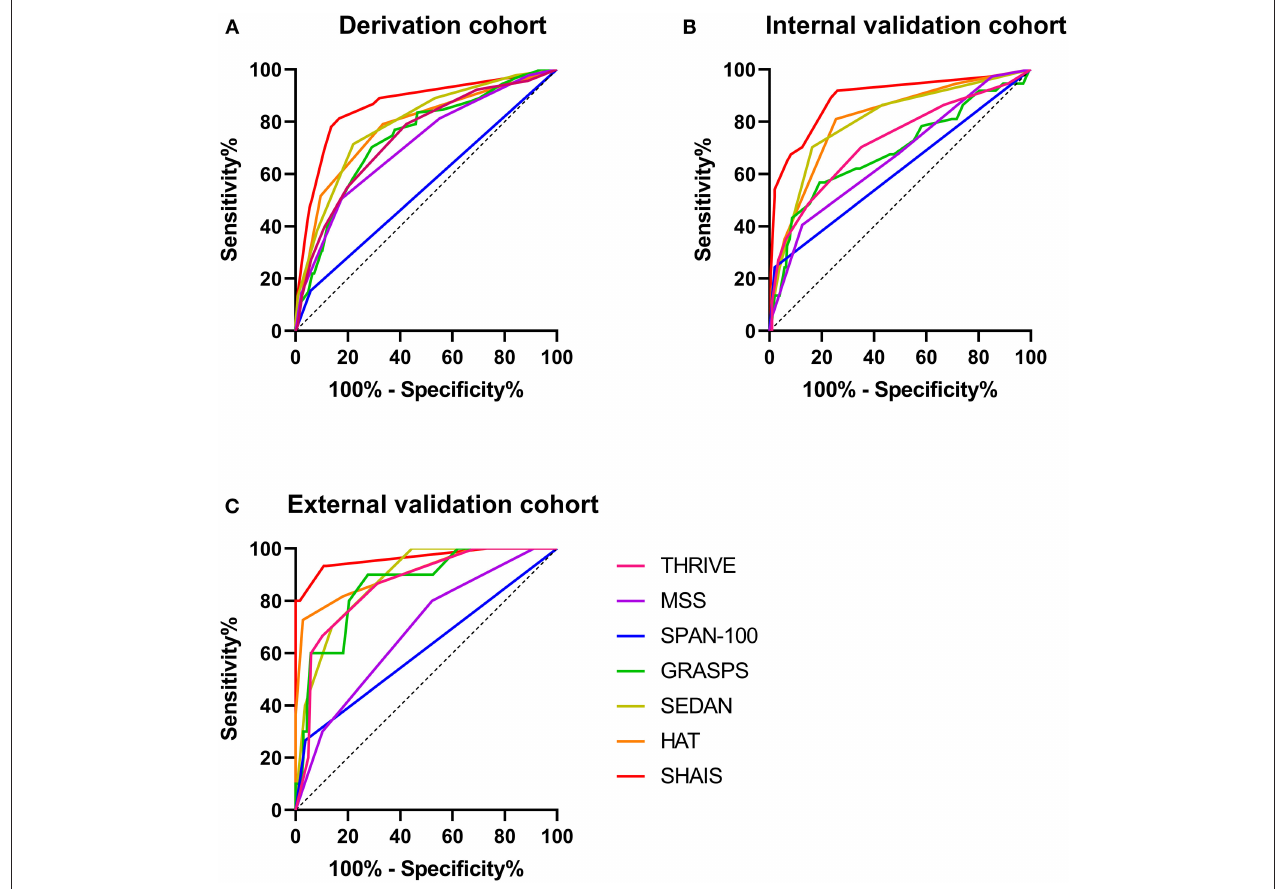
FIGURE 2 | Comparison of AUCs of six previous models and SHAIS score for the overall sHT in the derivation cohort (A) , the internal validation cohort (B) , and the external validation cohort (C) . AUC, area under the receiver-operating characteristic curve; sHT, spontaneous hemorrhagic